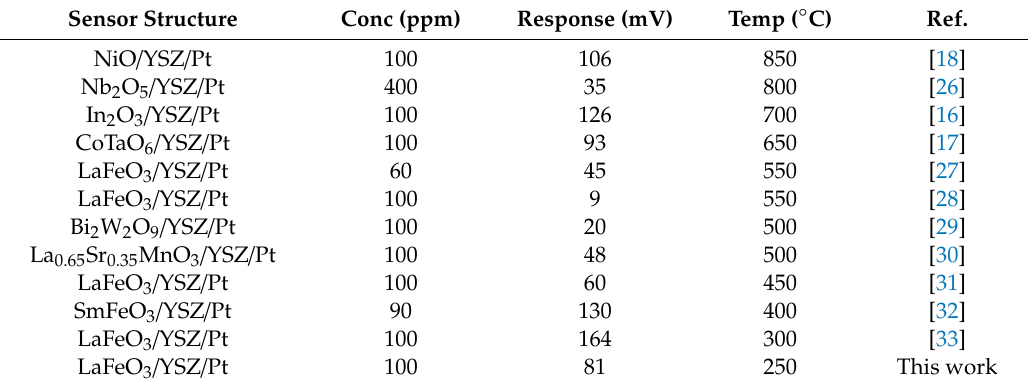
Table 1. Comparison of the mixed potential NO 2 type sensors operating temperature. Sensor